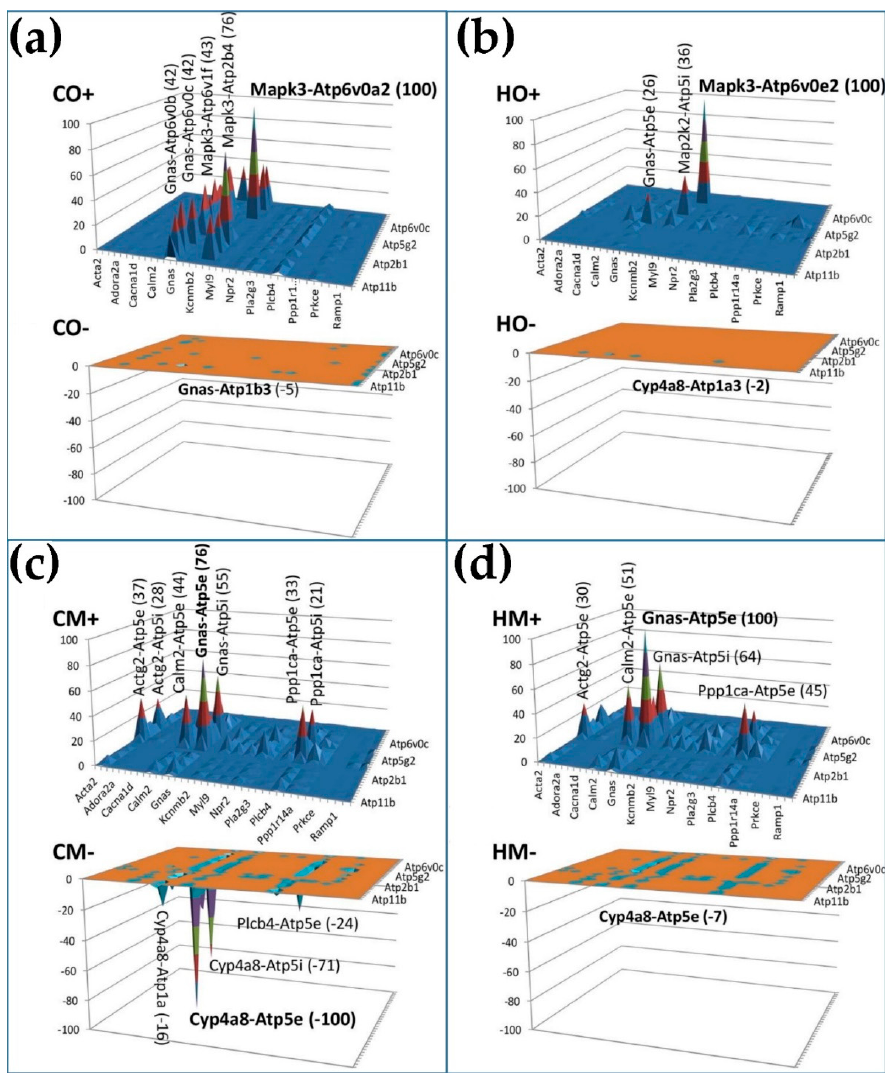
Figure 6. Gene pair prominence (GPP) analysis of the interaction of vascular smooth muscle contraction genes with the ATPases in the four conditions. ( a ) GPP values for the 472 positively ( ρ > 0.9) and 36 negatively ( ρ < − 0.9) correlated gene pairs in CO; ( b ) GPP values for the 280 positively and four negatively correlated gene pairs in HO; ( c ) GPP values for the 455 positively and 115 negatively correlated gene-pairs in CM; ( d ) GPP values for the 262 positively and four negatively correlated gene-pairs in